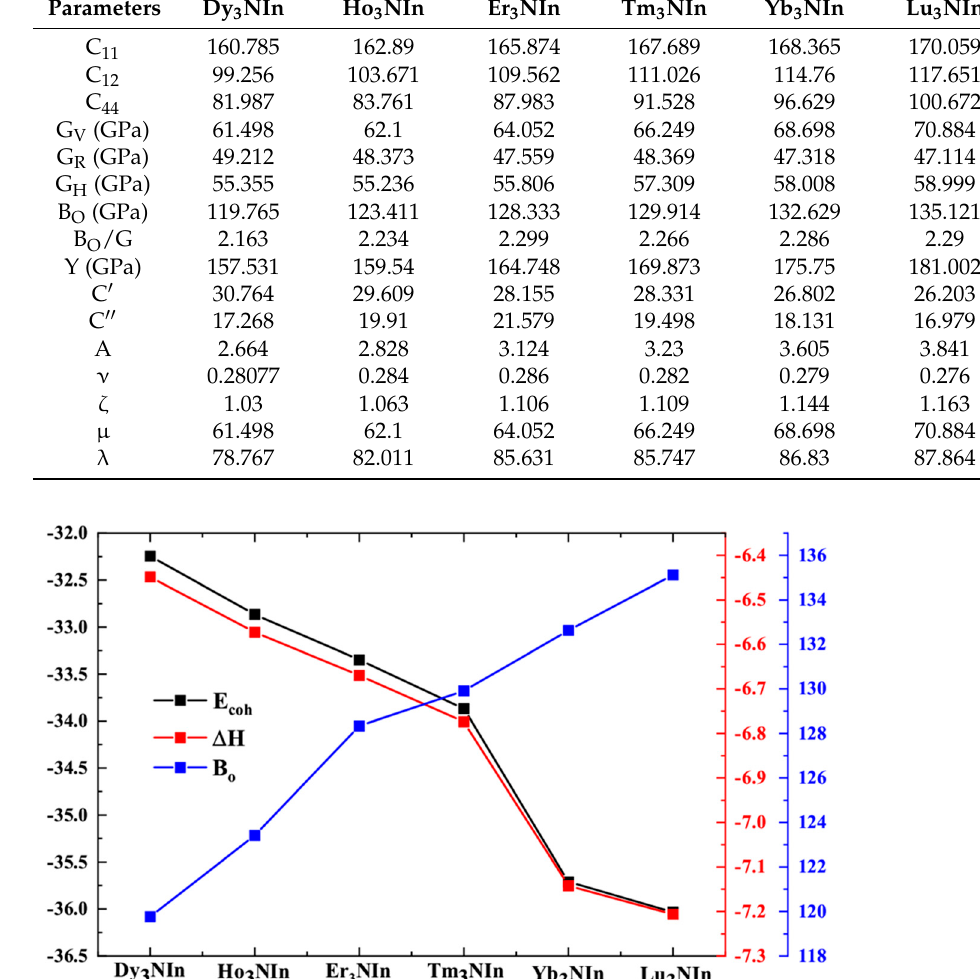
Figure 5. Cohesive energy, enthalpy of formation in comparison with the bulk modulus of the rare earth nitrides Ln 3 NIn (Ln = Dy-Lu) anti-Perovskite.